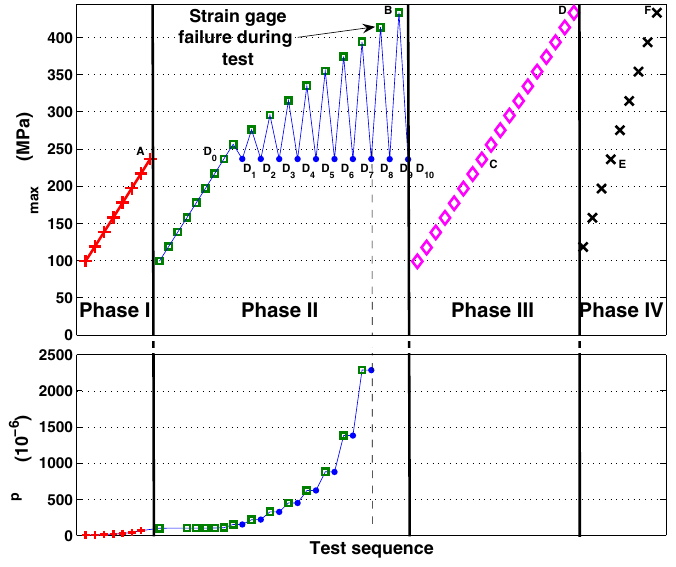
Fig. 2. Maximal stress σ max applied for each test and cumulated plastic strain (cid:15) p at the end of each test.